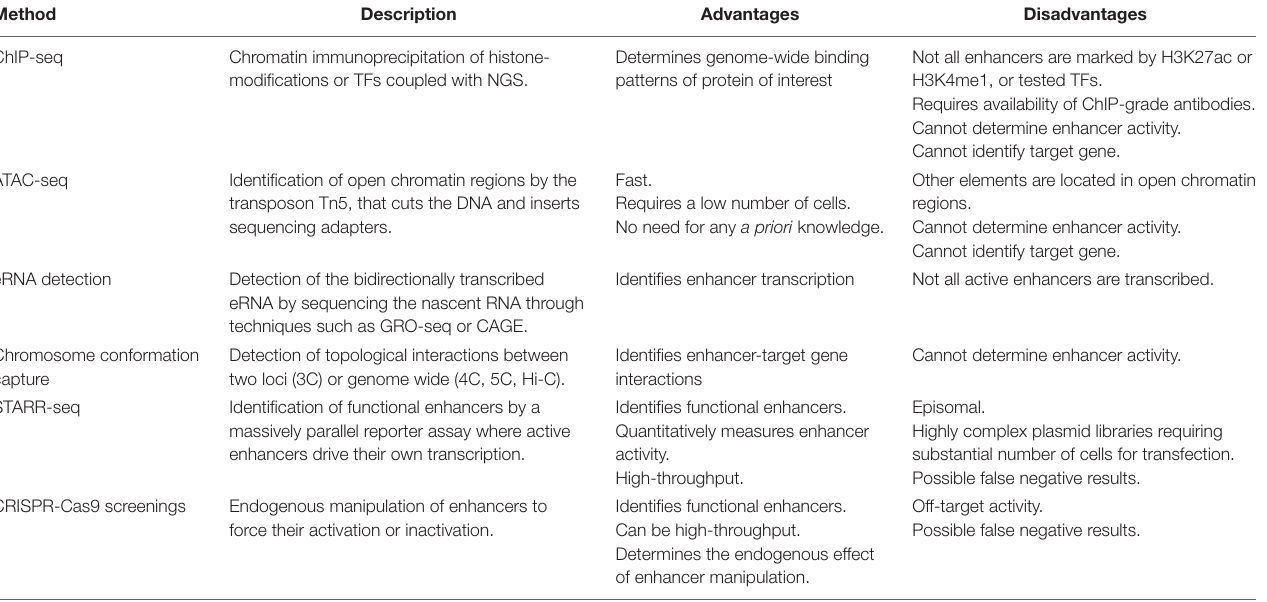
TABLE 1 | Methods for the identification of non-coding regulatory elements